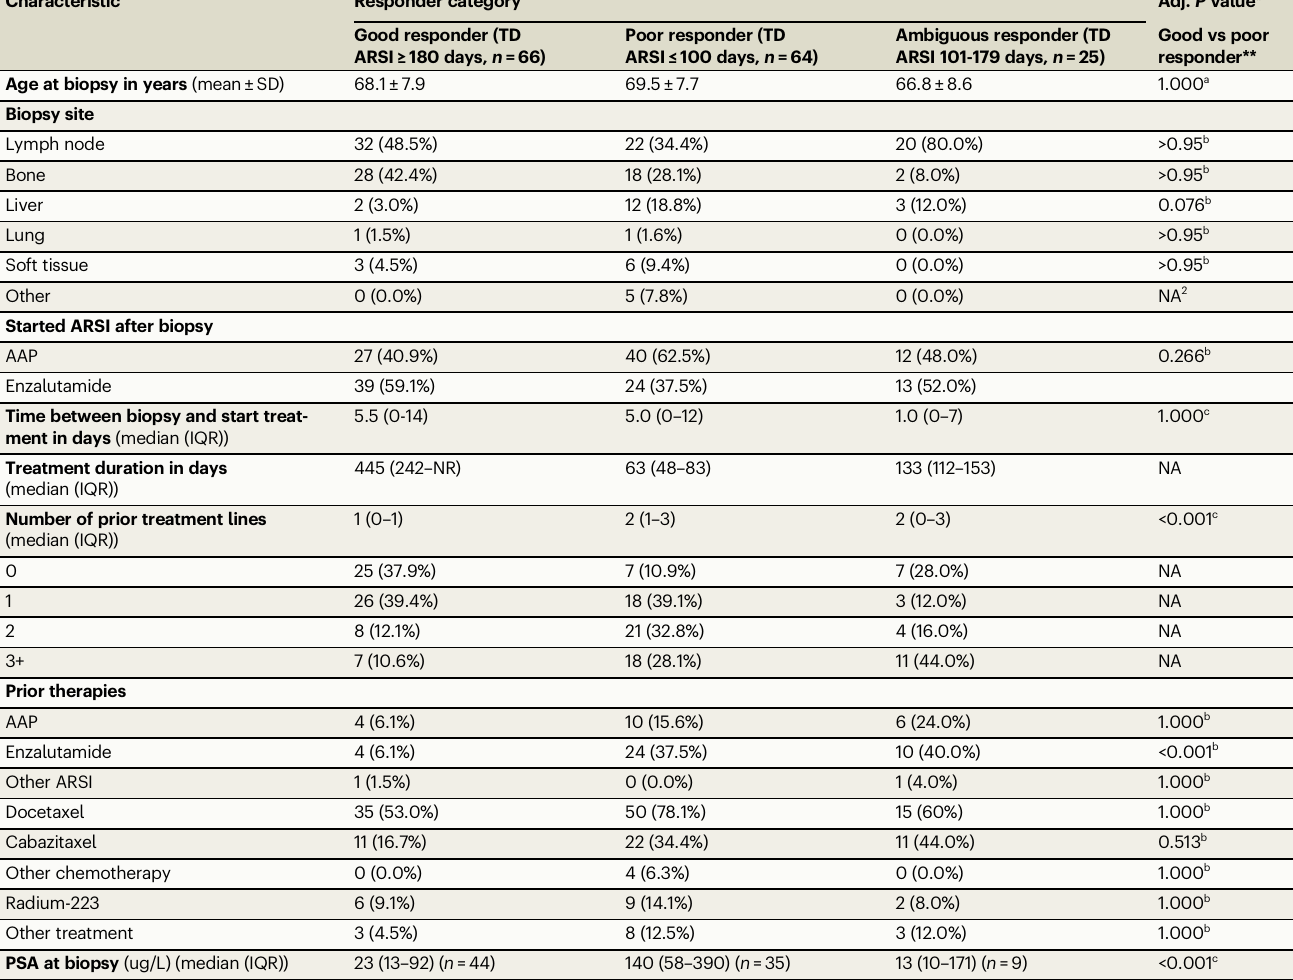
Table 1 | Baseline characteristics Baseline table of clinical characteristics of the CPCT-02 cohort (DR-071; December 19th 2021) Characteristic